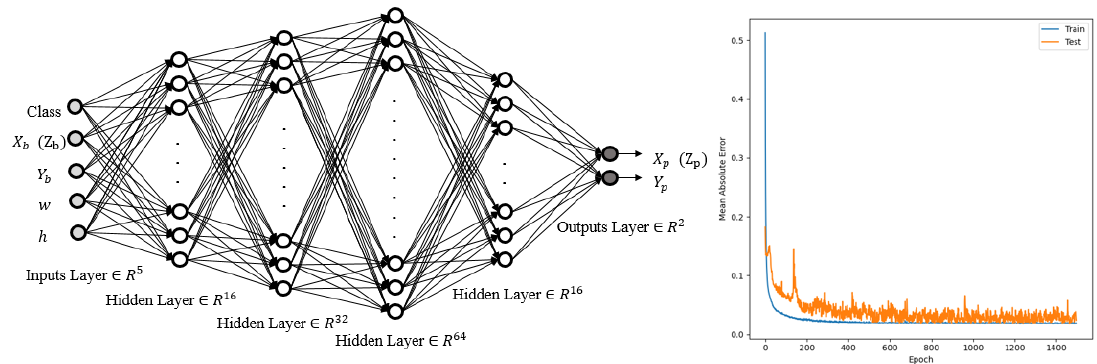
Figure 3. Structure of the first neural network and its mean absolute error convergence.